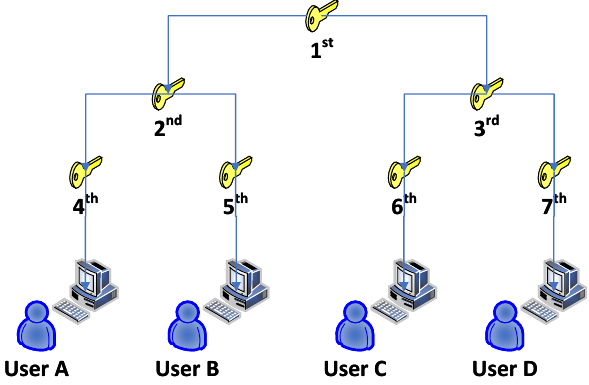
Figure 3. General architecture of